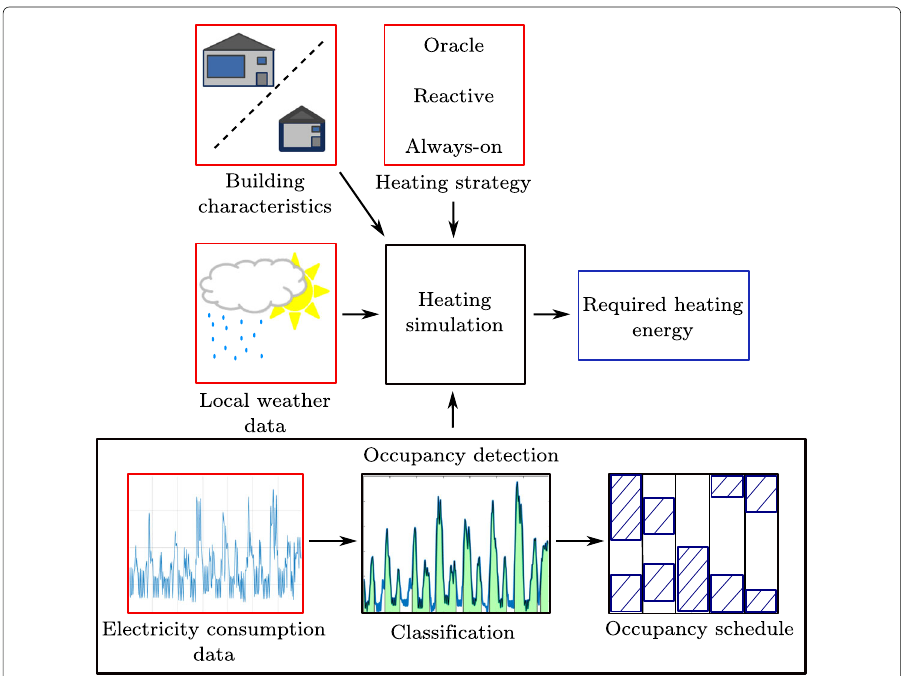
Fig. 1 An overview of our approach to determine the savings potential with inputs marked in red